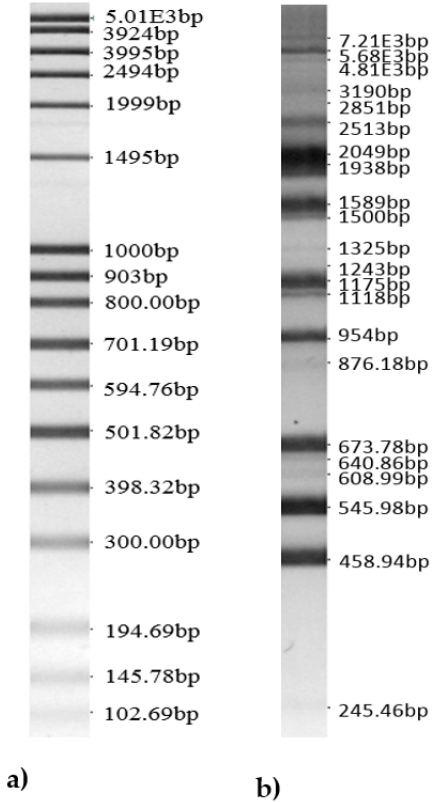
Figure 1. Bands of the isolated Lactobacillus uvarum LUHS245 genus. ( a ) 100bp DNA-ladder extended and ( b ) bands of isolated Lactobacillus uvarum LUHS245 genus).